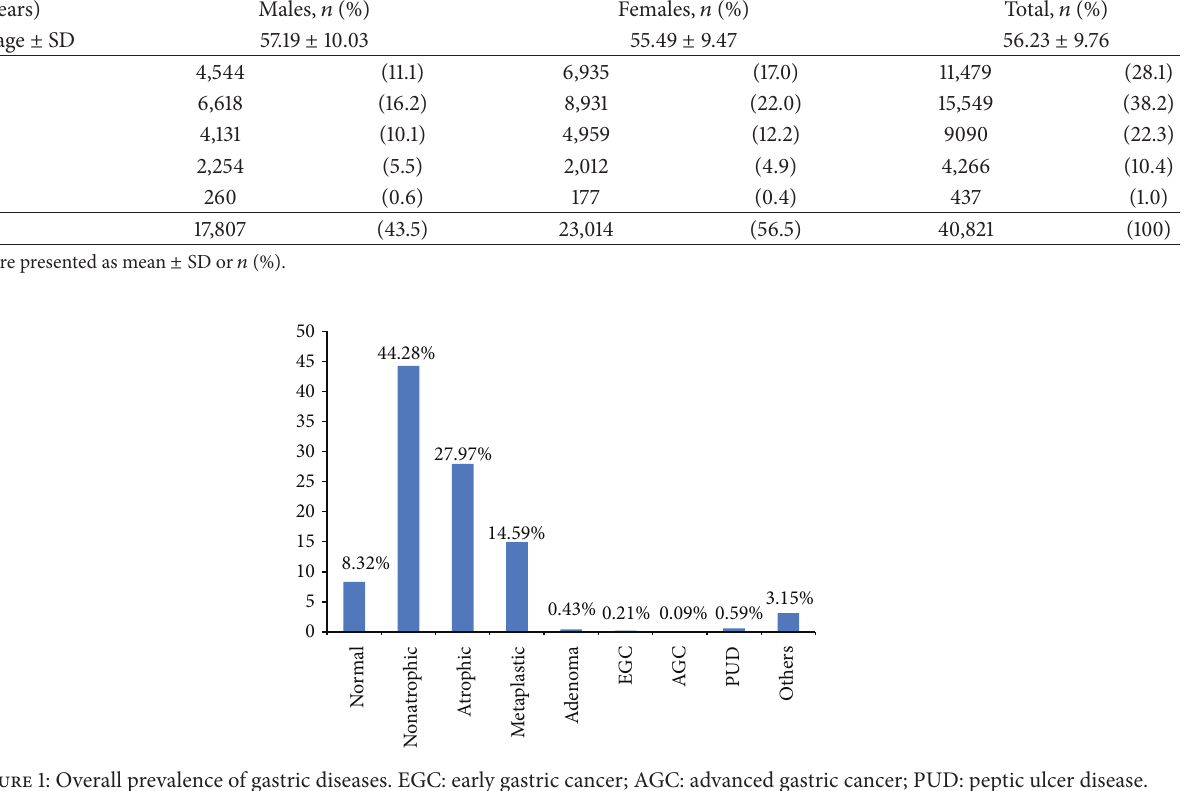
Table 1: Demographic characteristics of the study population.